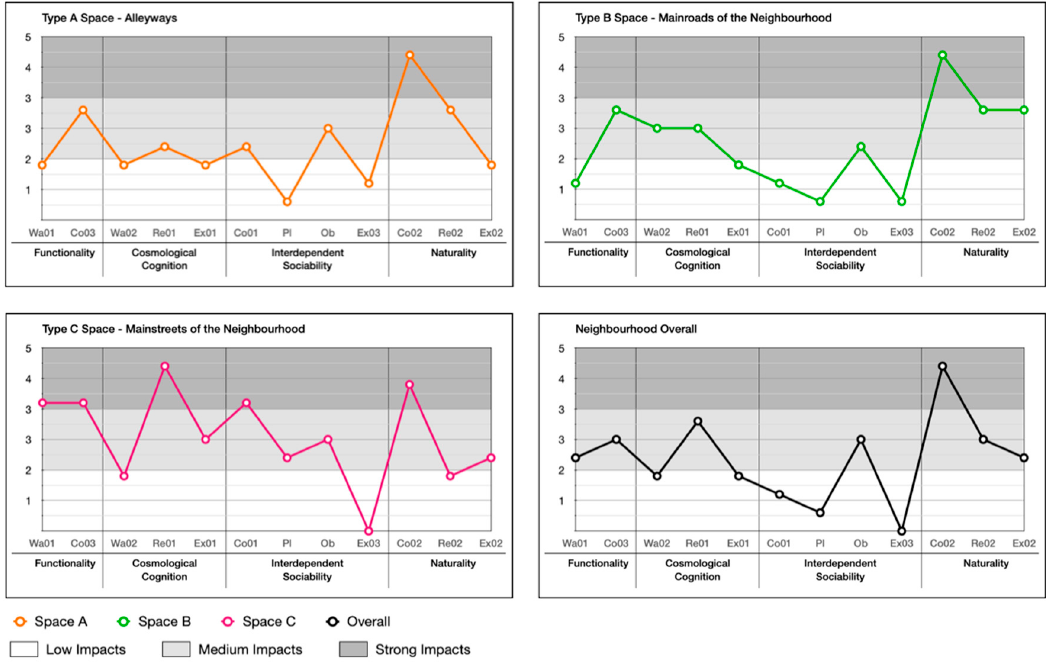
Figure 12. Impact score of each indicator of local place qualities on users’ perception of different types of space.